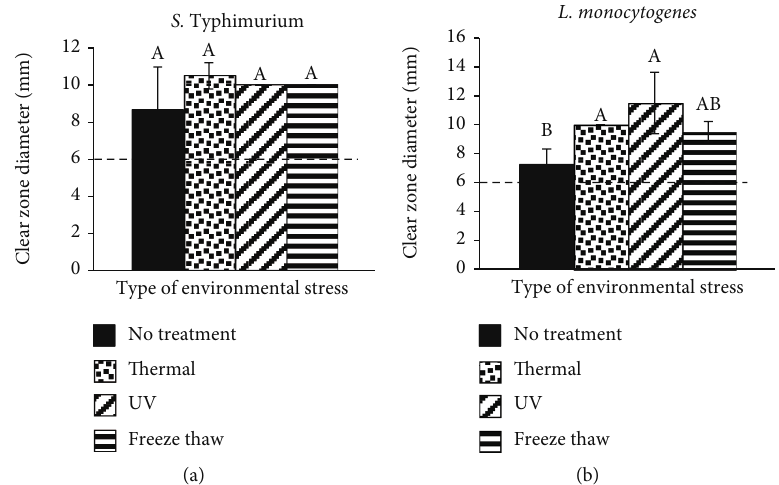
Figure 4: The e ff ect of various environmental stress on clear zone diameter (mm) of S. Typhimurium (a) and L. monocytogenes (b). Values are means ± standard deviations ( n = 3 ). Inhibition zone includes diameter of disc (6 mm). Di ff erent letters show statistically signi fi cant di ff erences between values ( p < 0 : 05